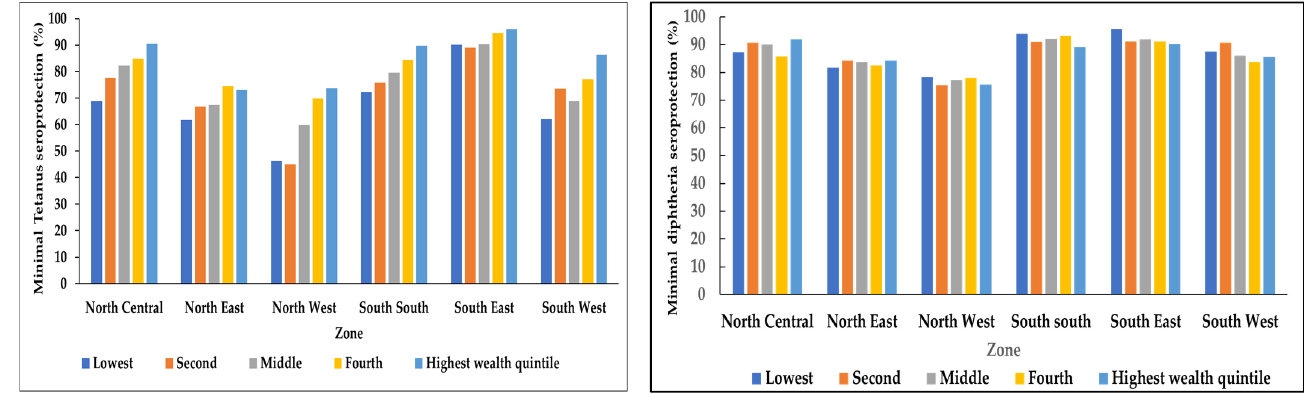
Figure 3. Tetanus and diphtheria at least minimal seroprotection ( ≥ 0.01 IU/mL) among children aged <15 years by zone and wealth quintile, Nigeria, 2018 ( a , b ).